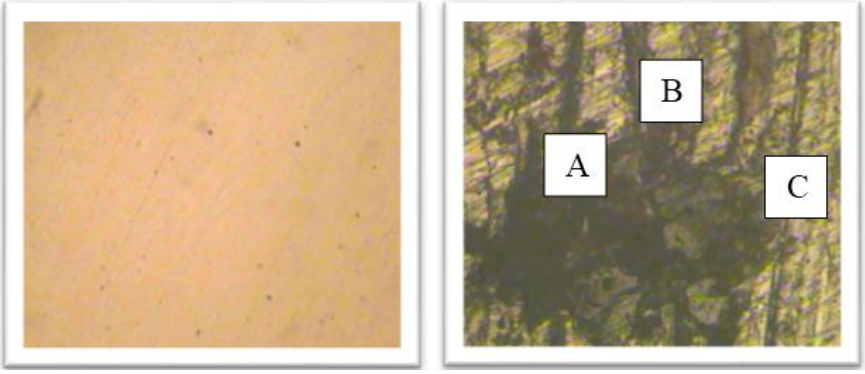
Figure 2. Corroded surface of carbon steel (mild steel) in das